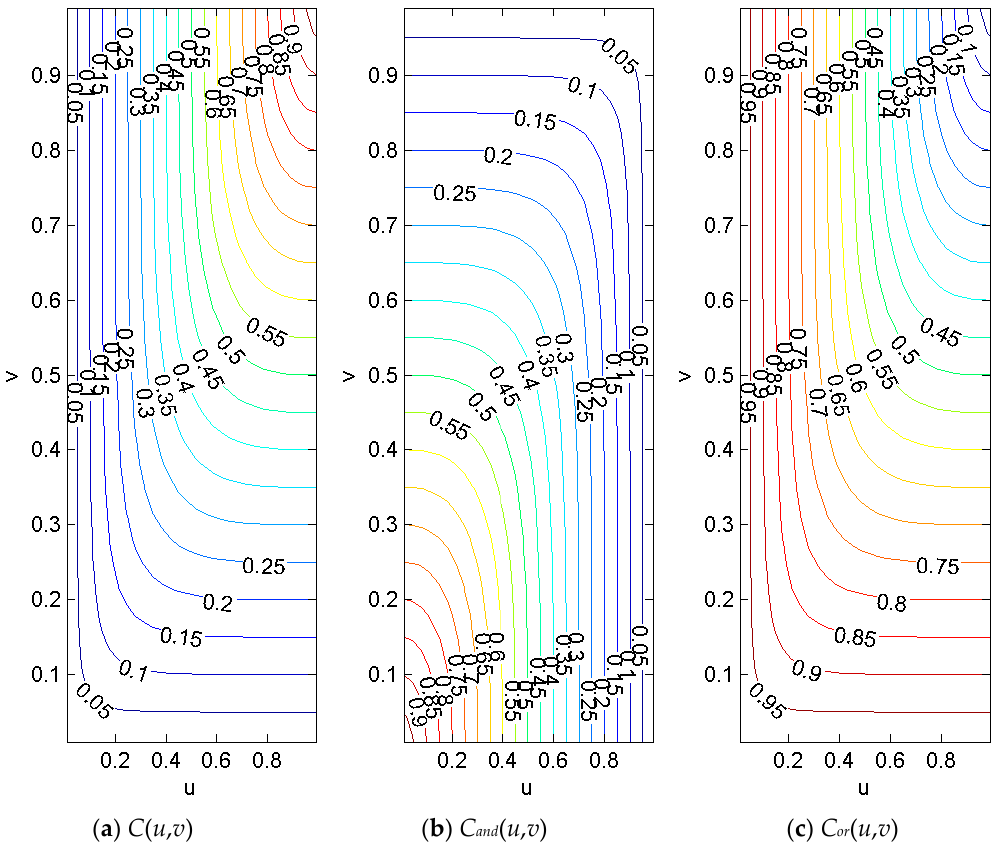
Figure 9. Contour map of C ( u , v ), C and ( u , v ), and C or ( u , v ).